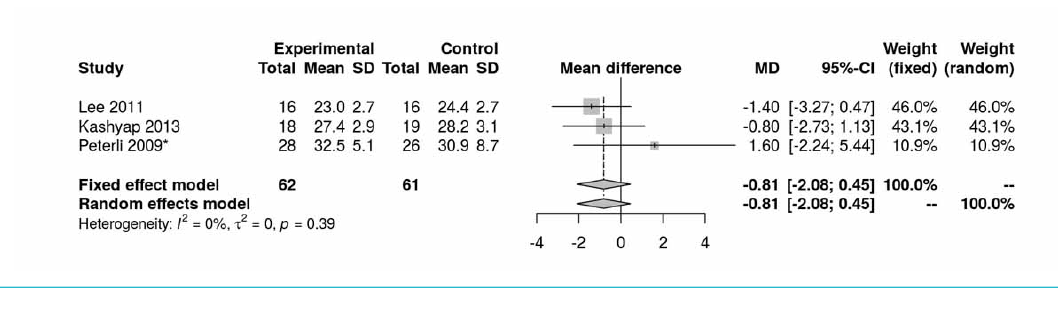
Figure 7a: Fasting blood glucose at 12 months diabetic only (analysis of studies including only patients with type 2 diabetes).